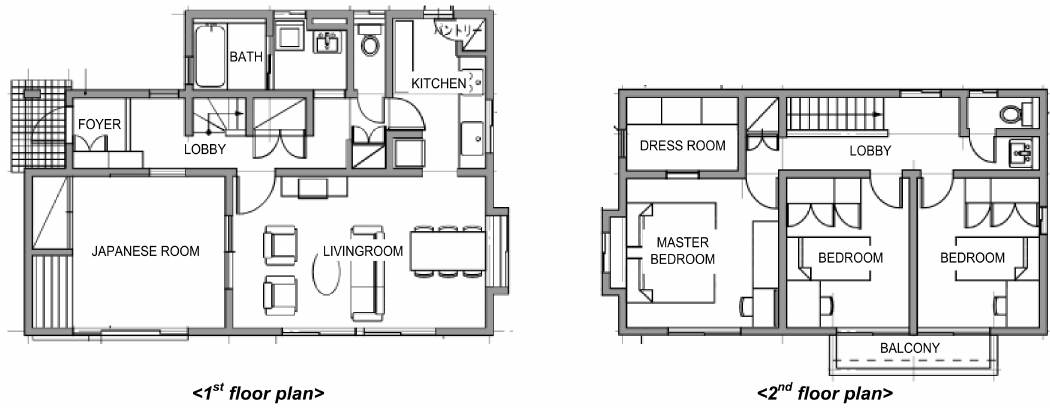
Figure 3. Floor plan of a reference